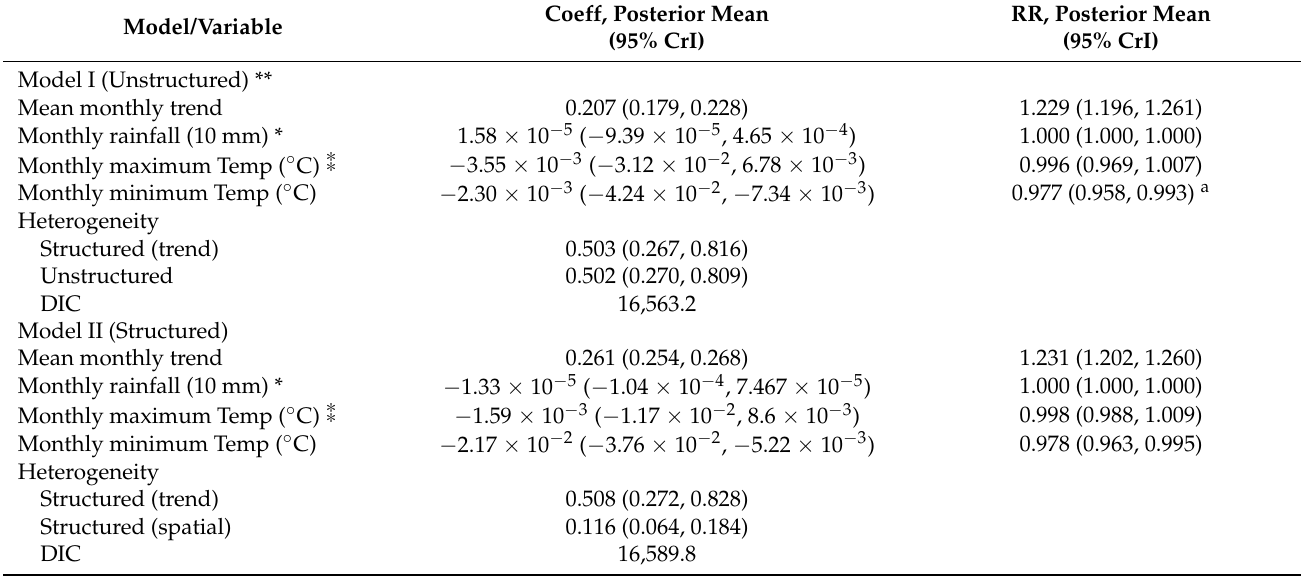
Figure 4. Spatial negative binomial regression analysis. ( a ) Unstructured random effects of malaria in Model I; ( b ) Trend analysis during the study period, 2015–2019. Source: Authors’ own contributions.